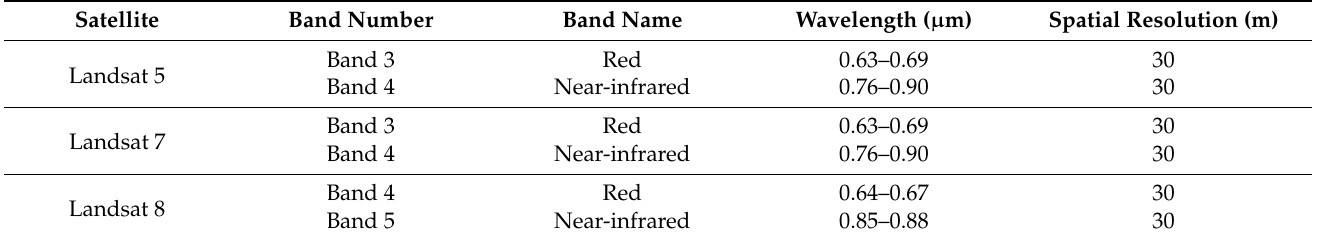
Table 1. Band information of the images used for calculating the NDVI.